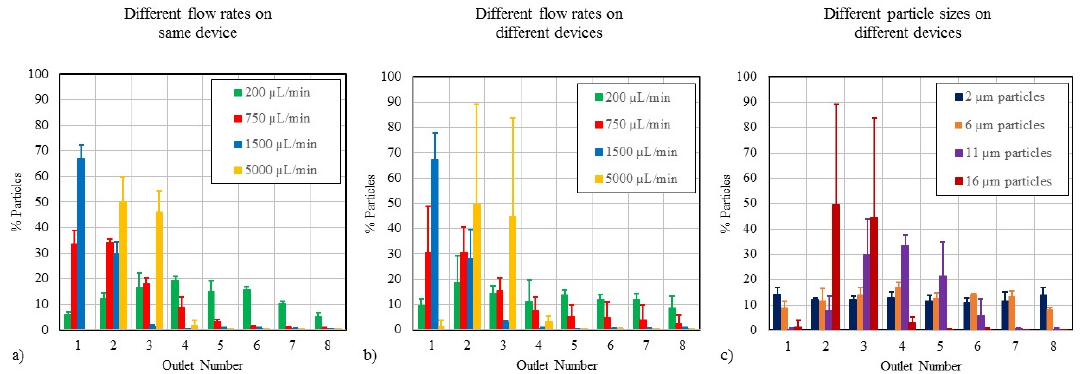
Figure 4. ( a ) Reusability associated with using the same microchannel multiple times (n = 3 repeats) for Design 1 with 16- µ m particles. ( b ) Single-use testing of three replicate microchannels (Design 1) with 16- µ m particles. ( c ) Single-use testing at 5000 µ L / min for di ff erent particle sizes using Design